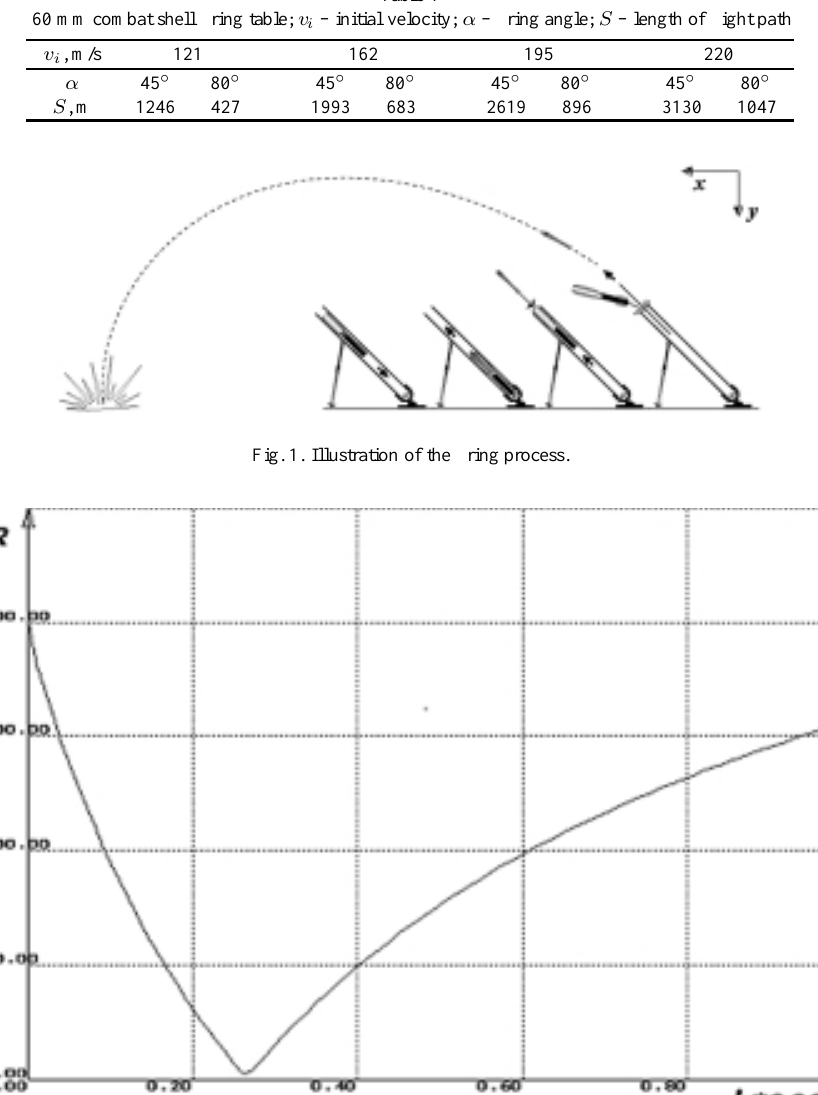
Fig. 2. Minimization of parameter h for combat